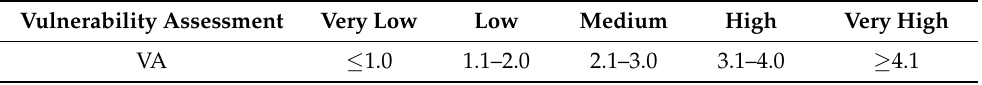
Table 13. Classification according to VA ranges.